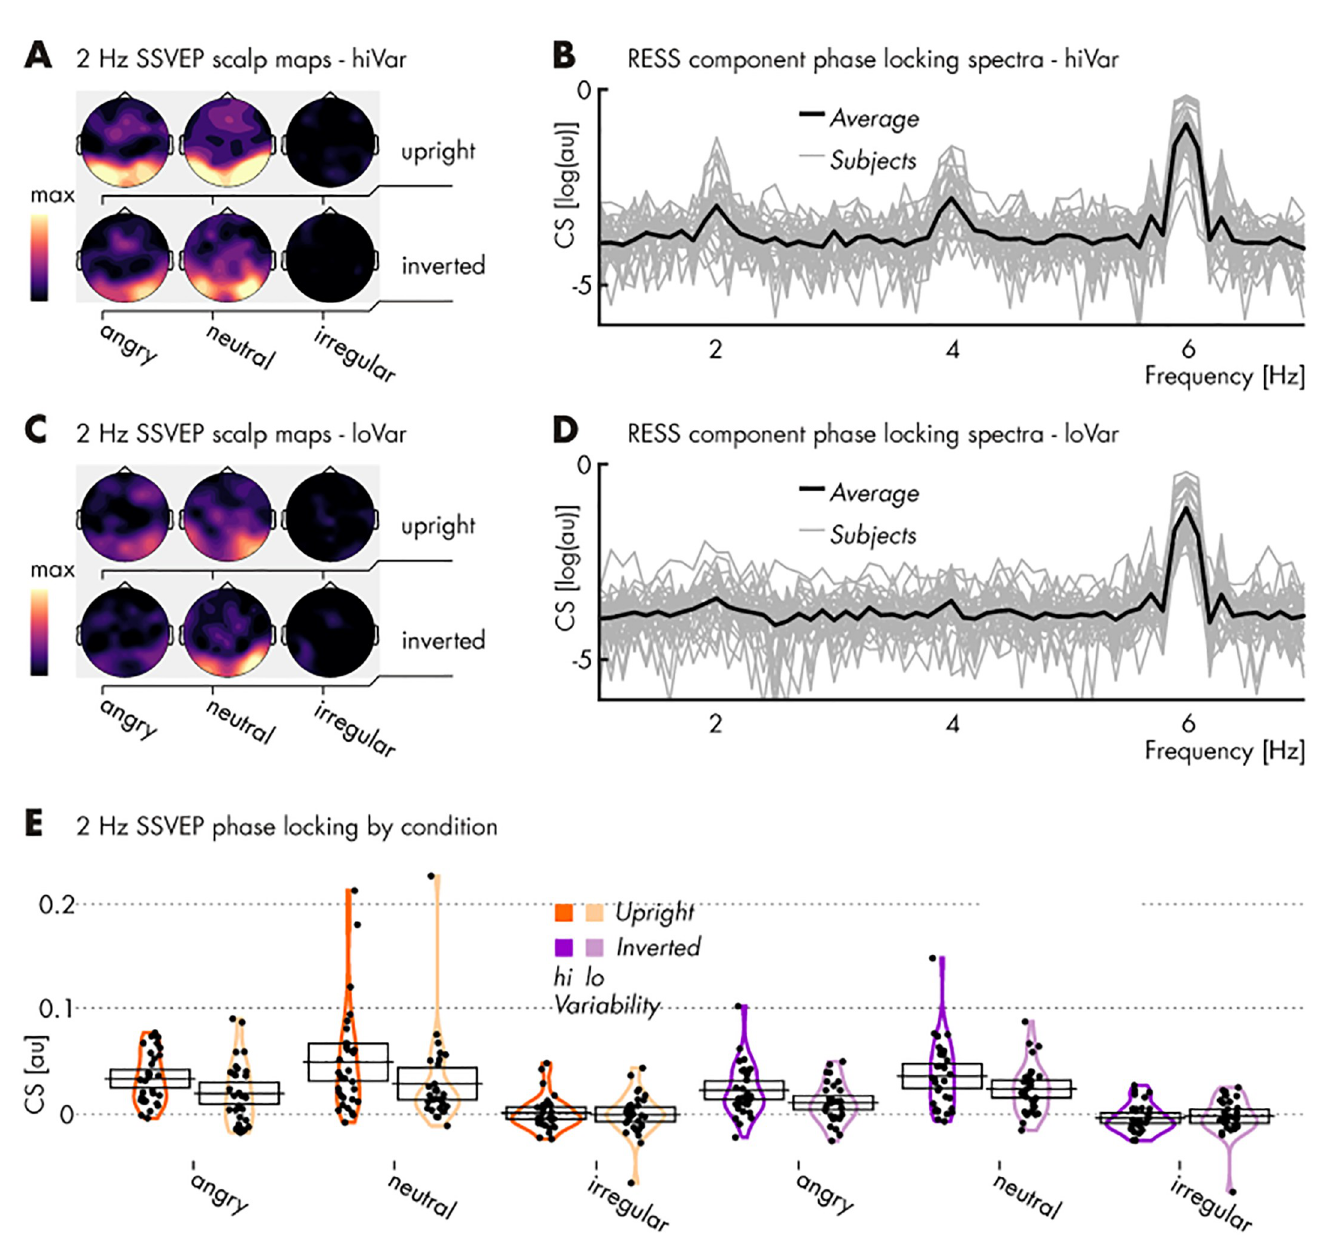
Fig 5. Spectral characteristics of EEG responses to stimulation in Experiment 1 . ( A ) Topographical distributions of phase-locking, quantified as cosine similarity (CS), at the regularity frequency of 2 Hz for high variance stimuli. Note the lack of phase-locking, i.e. consistent responses to the irregular stimulation conditions (maps same scale, in arbitrary units); ( B ) CS index of phase locking across the EEG spectrum (arbitrary scale) with the group average superimposed on single subject spectra, based on RESS spatial filter projections and collapsed across conditions featuring a regular presentation of high variance stimuli (i.e., excluding irregular stimulation conditions for their lack of signal; see A ). For visualization only, CS has been converted to log(CS); ( C & D ) Same as in panels A & B (identical scale) but for 2 Hz SSVEPs driven by low variance stimulation; ( E ) CS at the regularity frequency for each participant (single dots) and condition. Mean values are marked by horizontal black lines and 95% confidence intervals represented as transparent boxes. See Table 3 for specific results of statistical